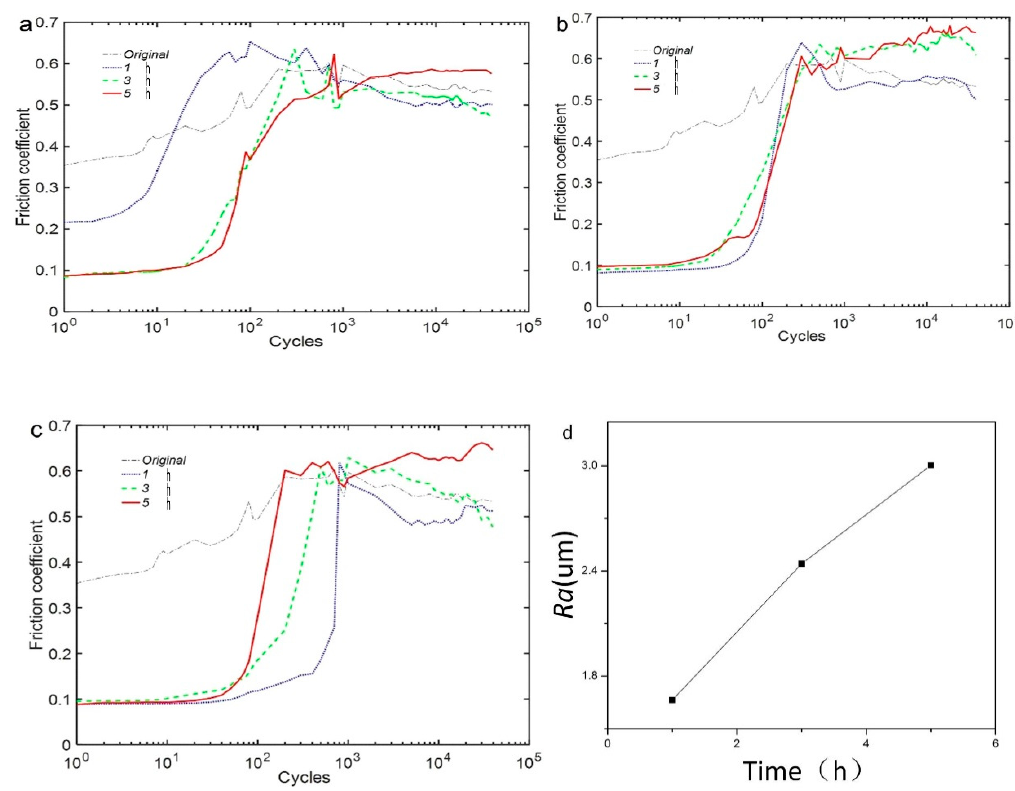
Figure 8. Friction coefficients of thermal oxidation-treated samples under the oxidation temperature of ( a ) 200 °C , ( b ) 300 °C, and ( c ) 400 °C as a function of the number of cycles. Roughness of thermal oxidation-treated samples under the oxidation temperature of ( d ) 300 °C .